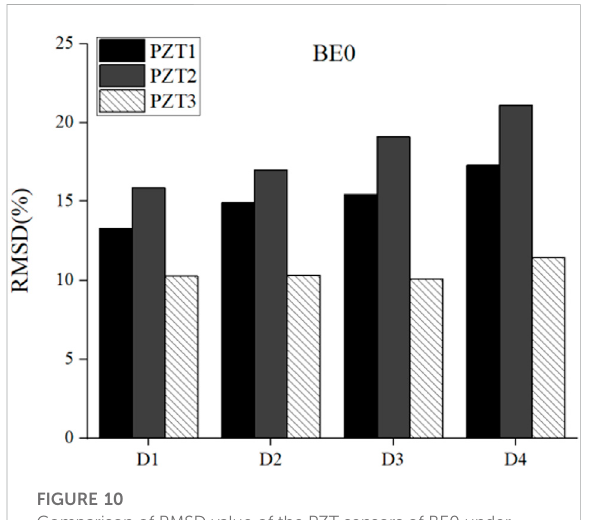
FIGURE 10 Comparison of RMSD value of the PZT sensors of BE0 under four damage scenarios. FIGURE 12